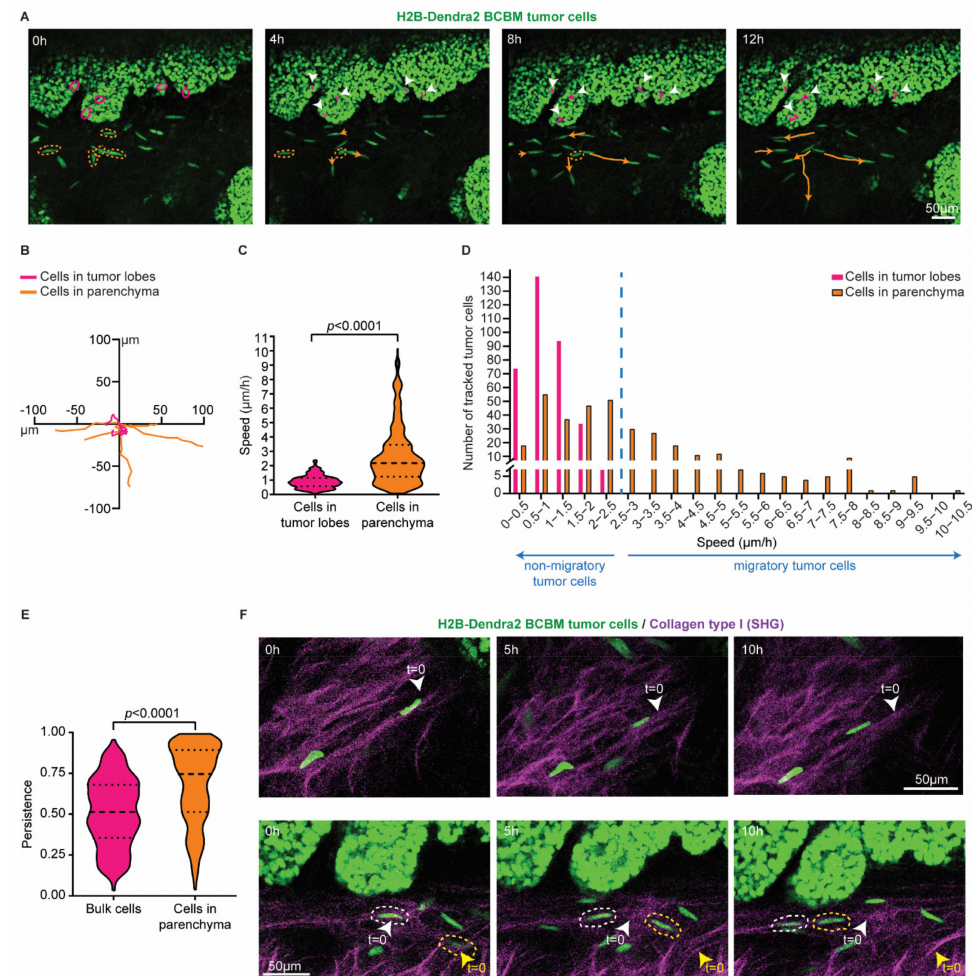
Figure 2. Single cells at the invasive front of BCBM are highly migratory. ( A ) Representative still images from a time-lapse multi-photon tracking of BCBM through a cranial window. BCBM tumor cells expressing H2B-Dendra2 were imaged every hour for up to 12 h. Randomly picked cancer cells located in the tumor lobe or brain parenchyma are marked with a circle in magenta and orange, respectively. Tracks are depicted once cells move. Migratory tracks depict the total movement of tumor cells in the tumor lobes (magenta tracks and white arrowheads) and brain parenchyma (orange tracks). ( B ) Rose plot representation of the migratory tracks with a common origin of tumor cells displayed in ( A ). ( C ) Quantification of the speed of tumor cells in the tumor lobes (magenta) or brain parenchyma (orange); n = 350 tumor cells per condition imaged in 3 mice; p -value was determined using a Mann–Whitney t -test, two-tailed. ( D ) Distribution of tumor cell speed for cells present in the tumor lobes and in the brain parenchyma. ( E ) Quantification of the persistence of migratory tracks from a total of 350 tumor cells per condition from 3 mice. p -value was determined with a Mann–Whitney t -test, two-tailed. ( F ) Representative still images of a time-lapse multi-photon movie showing the migration of BCBM tumor cells along crosslinked collagen type I fibers (SHG channel) in two distinct